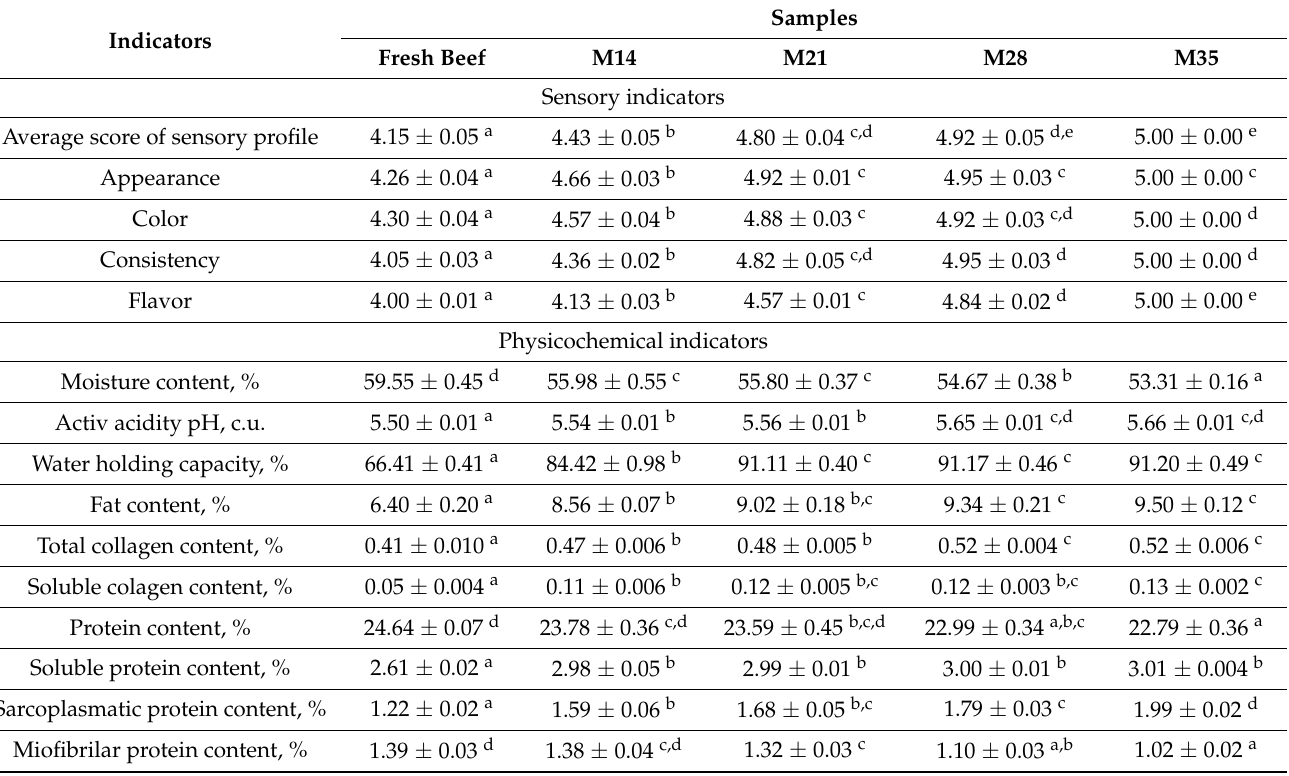
Table 2. Sensory and physicochemical indicators of dry-aged beef (the results are presented as means ± standard